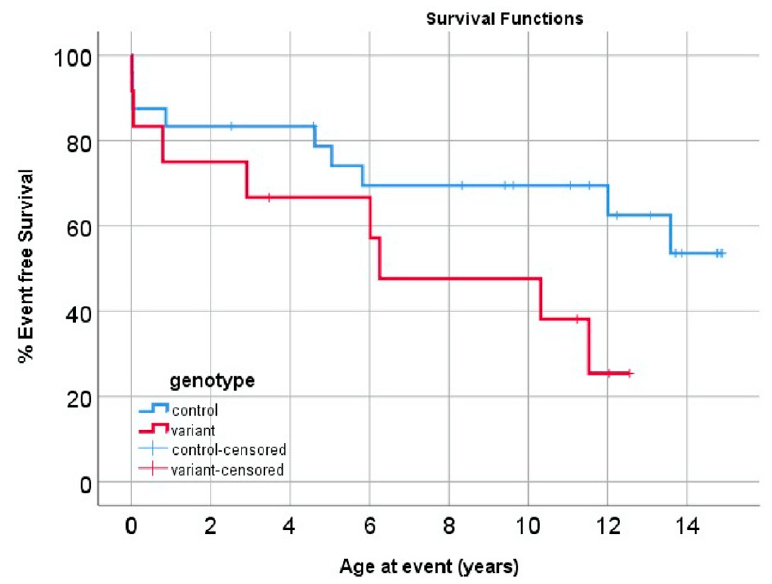
Figure 1. Event-free survival analysis comparing 36 HLHS patients. A total of 12 patients had rare, predicting damaging MYH6 variants. p -value = 0.074, log-rank test.